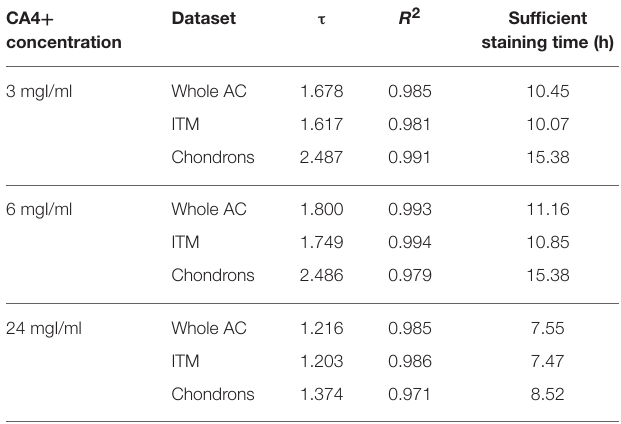
TABLE 1 | Main results.